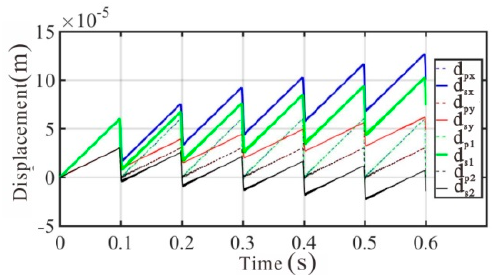
Figure 7. Results of two directions in the 2-DOF PIDM when driving under different voltages and the two 1-DOF PIDMs driving at the corresponding conditions.